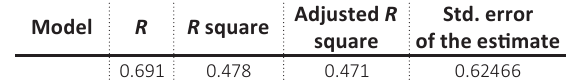
Table 3. IBPP model outline Model